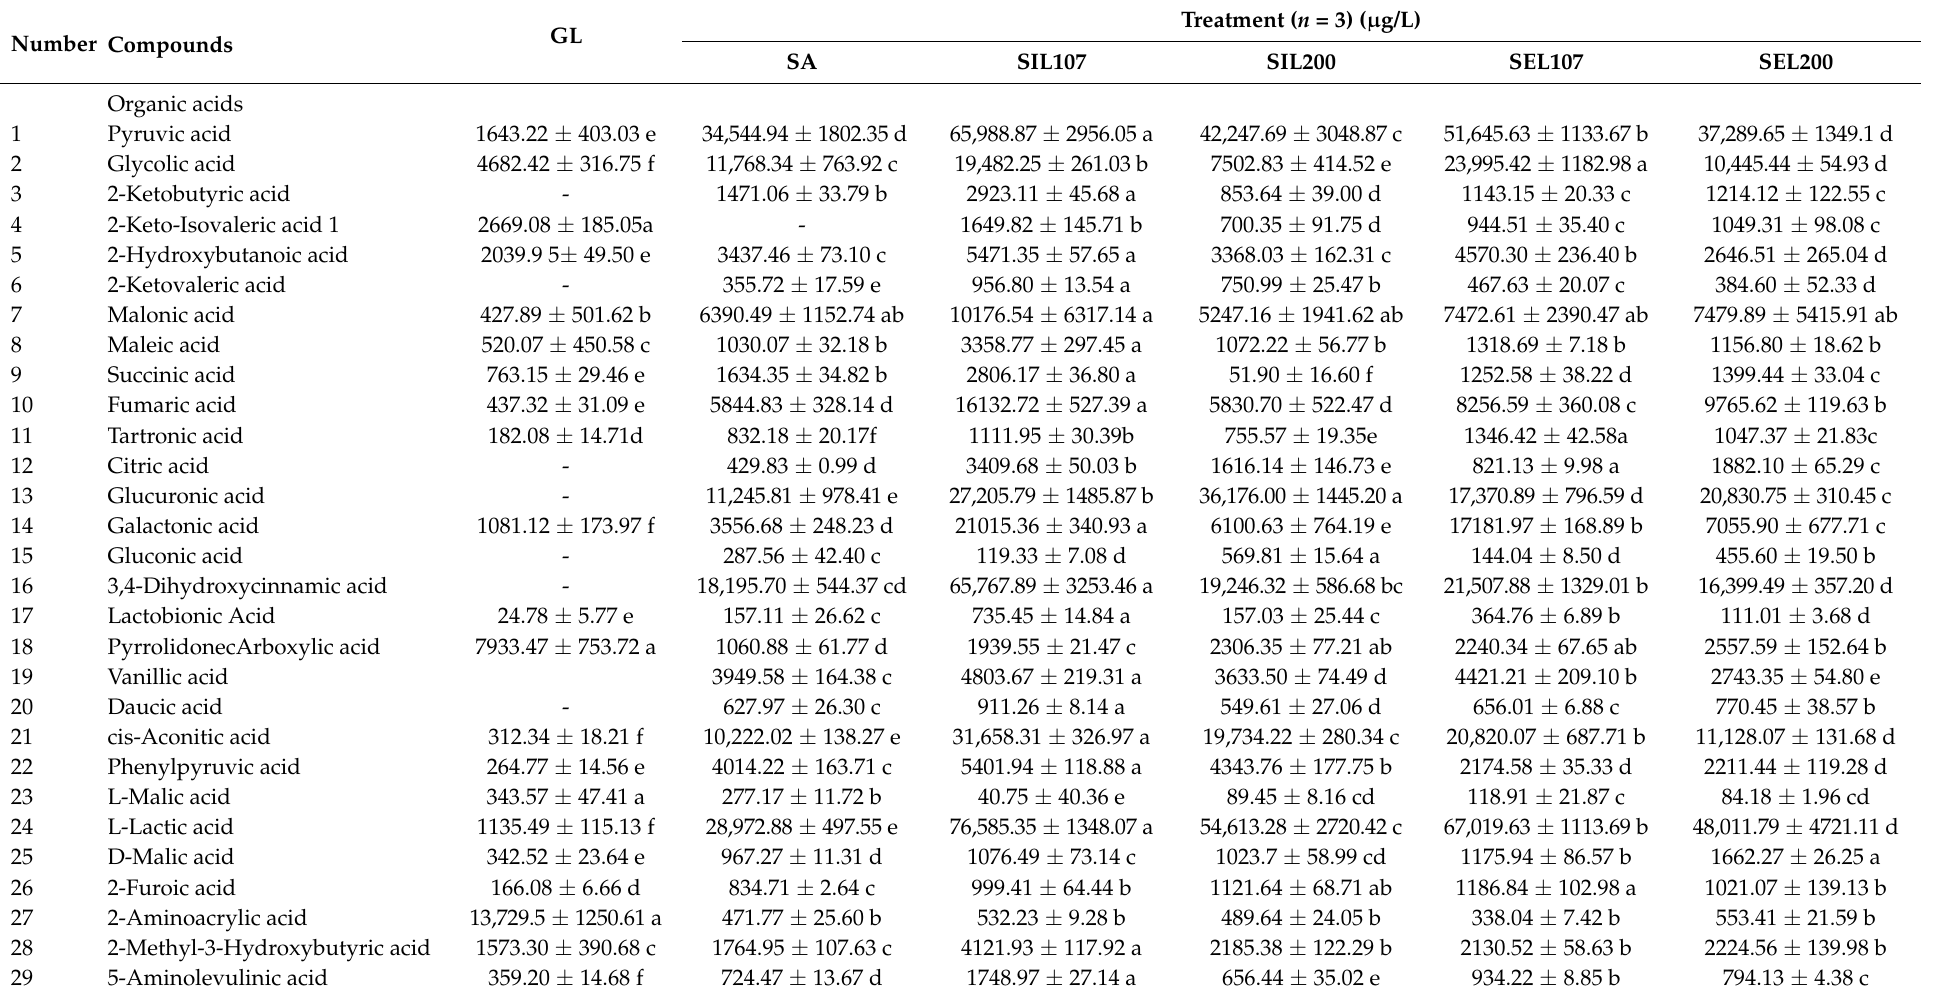
Table 2. Non-volatile compounds of apple juice and apple ciders produced by mono- and